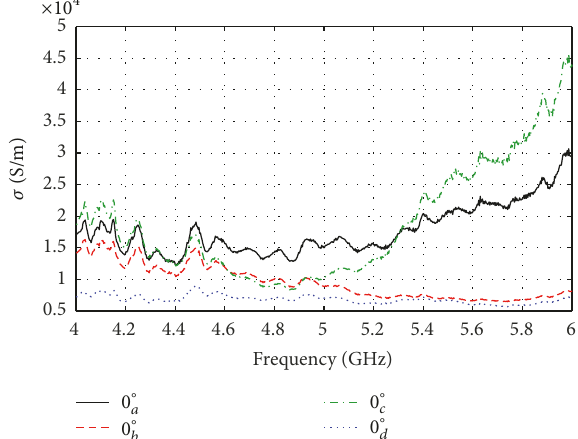
(perpendicular) [9] ( 8 – 12 GHz). The conductivity of the shred-CFRP is slightly higher than that of the twill-CFRP.